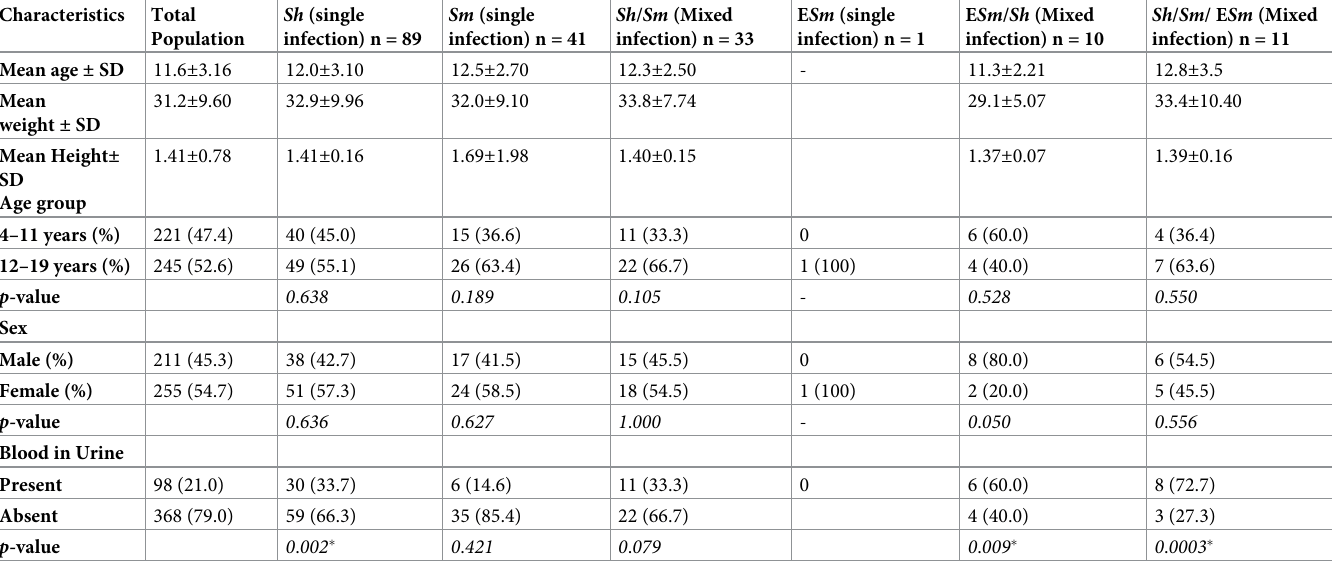
Table 1. General characteristics and prevalence of human schistosomiasis in the study population. Characteristics